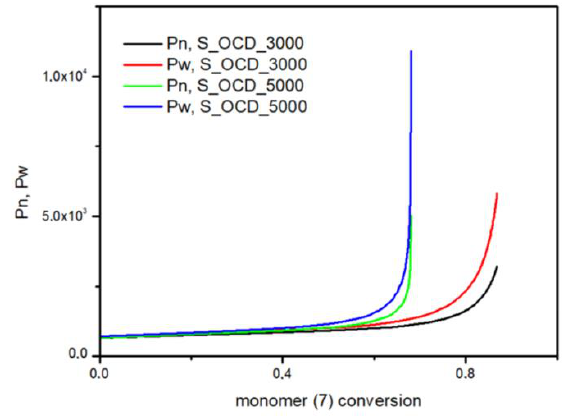
Figure 16. The number average molar mass (P n ) and the weight average molar mass (P w ) as a func- tion of conversion of the 1,10-decanediol added in second stage of synthesis.